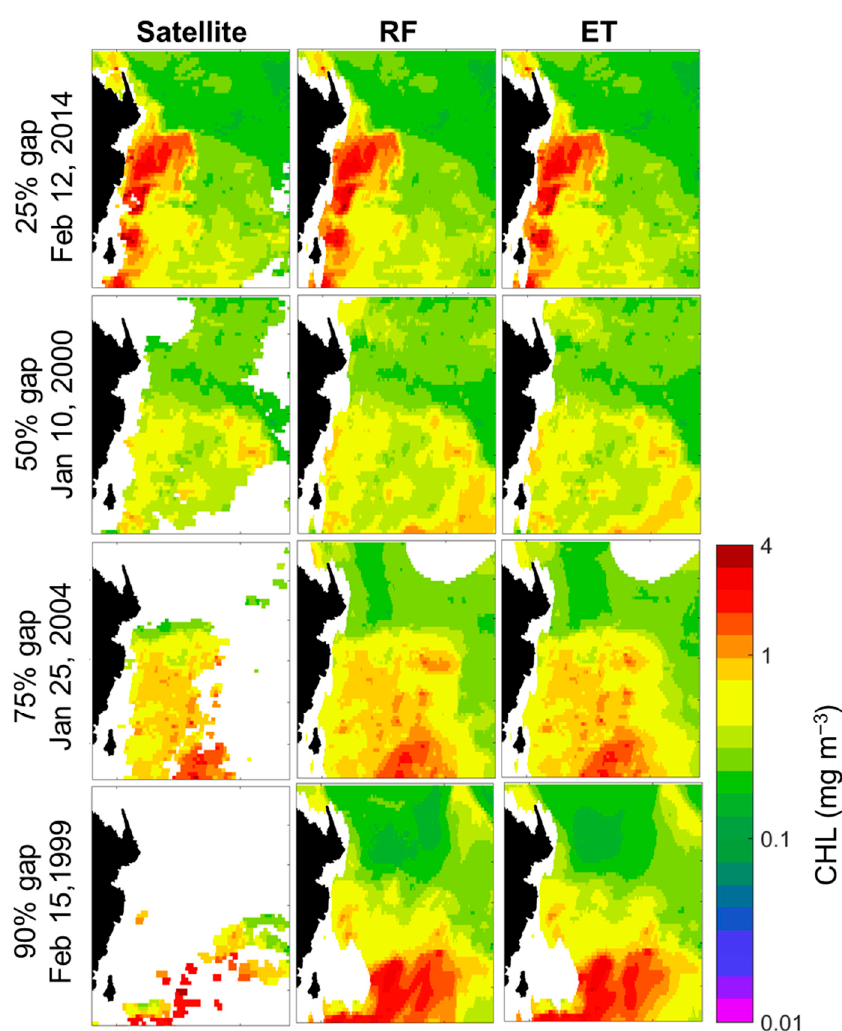
Figure 6. Daily spatial distribution of the satellite-derived CHL (left column) and the reconstructed CHL using the RF (middle column) and the ET (right column) model. The dates were selected to obtain gaps accounting for 25%, 50%, 75%, and 90% of the entire domain.